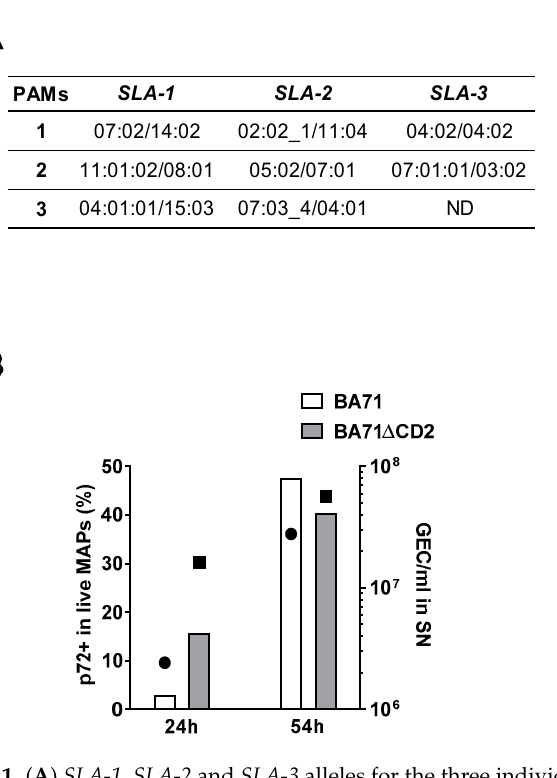
Figure 1. ( A ) SLA-1 , SLA-2 and SLA-3 alleles for the three individual pigs from which PAMs were extracted and used in the immunopeptidomics studies. Allele annotation from the IPD-MHC Database. ND: not determined due to low quality of the DNA sample; ( B ) percentage of ASFV-infected PAMs from a representative sample at 24 hpi and 54 hpi, as detected by flow cytometry using anti-p72 monoclonal antibody (bars) and the corresponding ASFV detection by qPCR in supernatants (circles for BA71 and squares for BA71 Δ CD2); ( C ) percentage of live PAMs from a representative sample at 24 hpi and 54 hpi detected by VIVID staining; ( D ) Western blot for the detection of SLA I molecules in supernatants (SN) of infected cell lysates after incubation with anti-SLA I-coupled sepharose beads, in the last sepharose wash before elution (Wash), or in the eluted SLA I-peptide complexes (Elution). M: molecular weight marker.